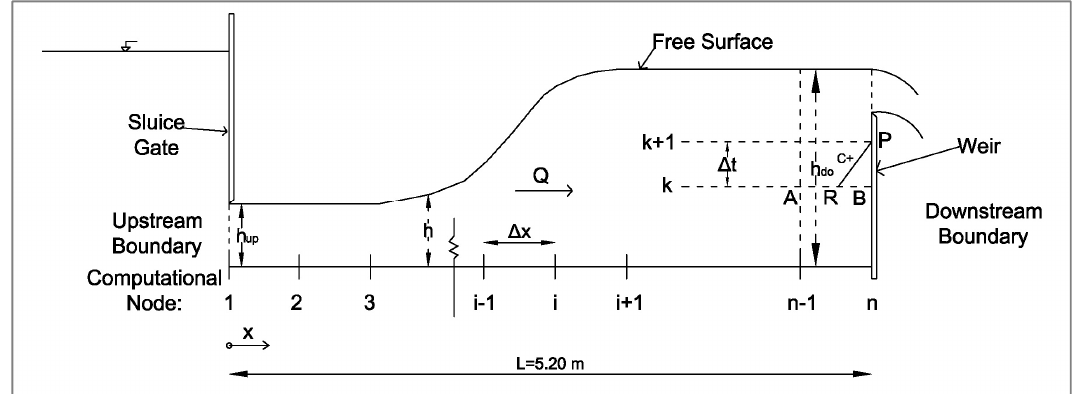
Figure 1. Physical and computational domain of the classical hydraulic jump.